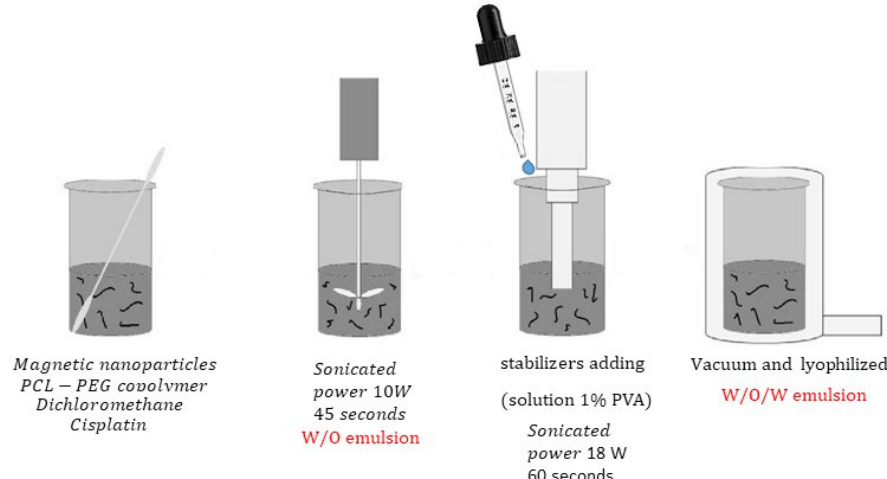
O magnetic nano-particles modified using PCL-PEG 3 4